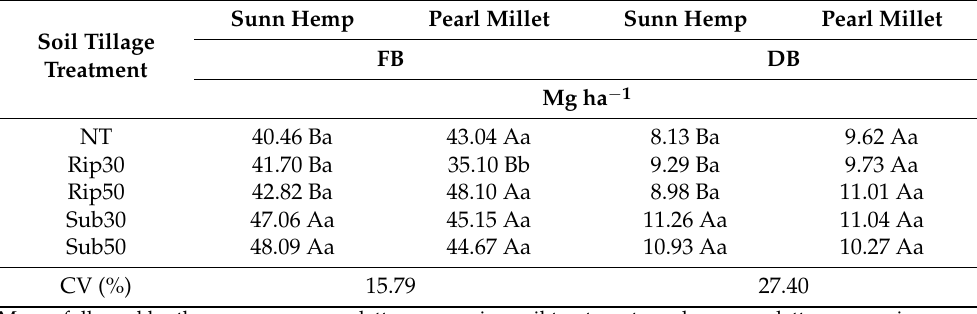
Table 3. Fresh above-ground biomass (FB *) and dry above-ground biomass (DB *) at the end of the crop cycle of sunn hemp and pearl millet under different treatments to alleviate soil